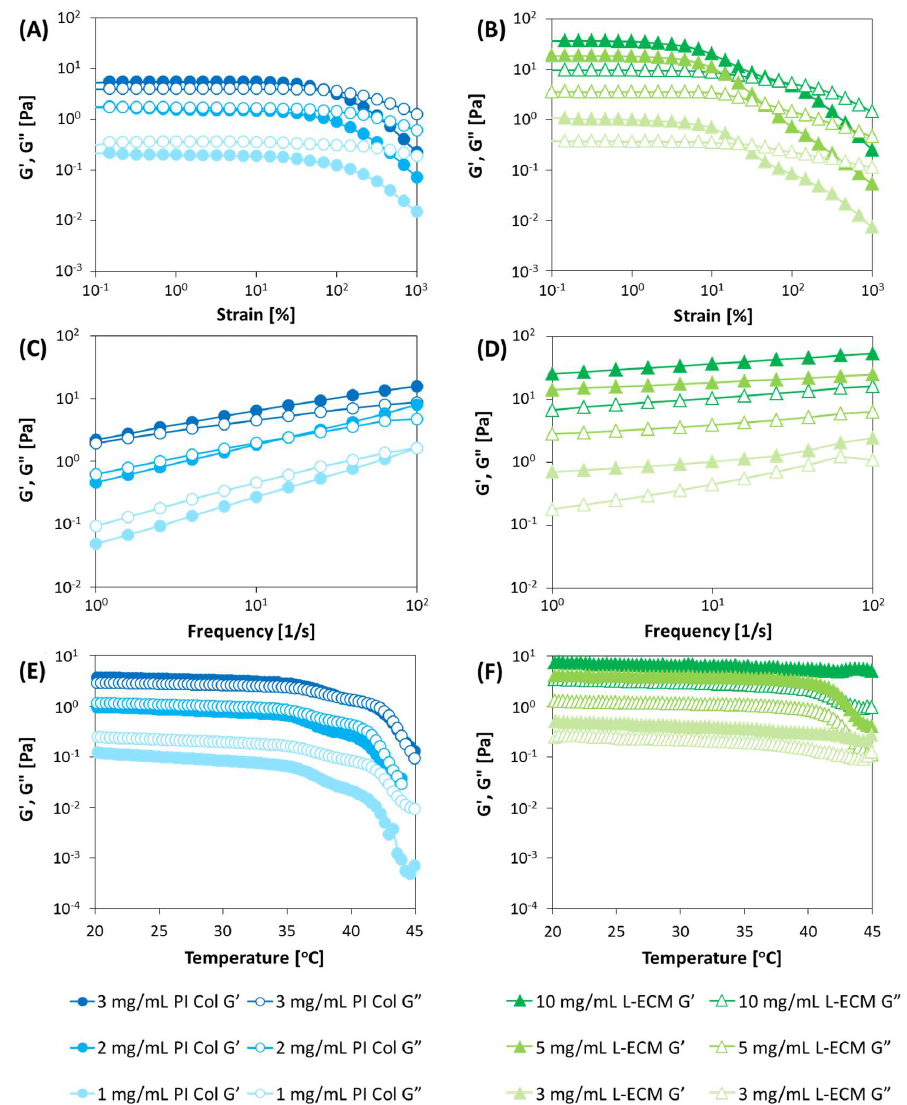
Figure 5. ( A , C , E ) Variations in G′ and G′′ at different concentrations of PI Col (3, 2, and 1 mg/mL), ( B , D , F ) L-ECM concentrations (10, 5, and 3 mg/mL). Corresponding variations of G′ and G′′ with ( A , B ) dynamic strain sweep (DSS) mode, ( C , D ) dynamic frequency sweep (DFS) mode, and ( E , F ) dynamic temperature ramp (DTR) mode measured by a rheometer (conditions for DSS: frequency 1 Hz, temperature 10 °C; conditions for DFS: strain 5%, temperature 10 °C; and conditions for DTR: frequency 1 Hz, and strain 5%). All samples were dissolved in an aqueous solution adjusted with HCl at pH = 3.0.